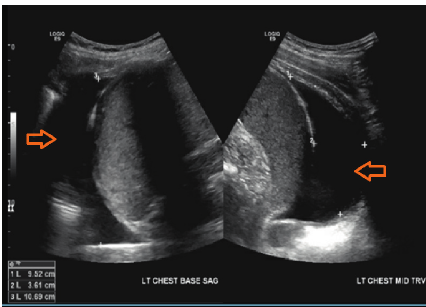
Figure 2: Ultrasound of the chest demonstrating a left simple pleural effusion measuring